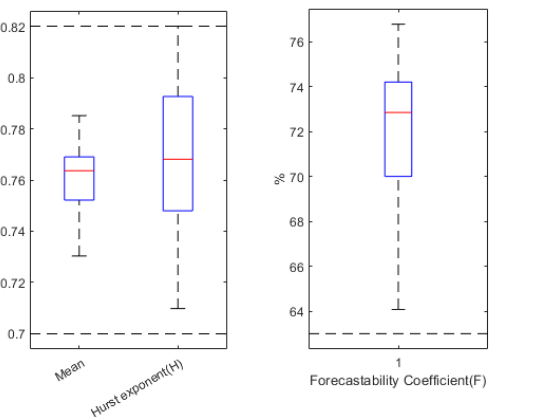
Figure 9. Boxplot: red line represents the median; blue lines represent the 3rd quartile (up) and 1st quartile (down); and black broken lines are the extremities — min and max values.